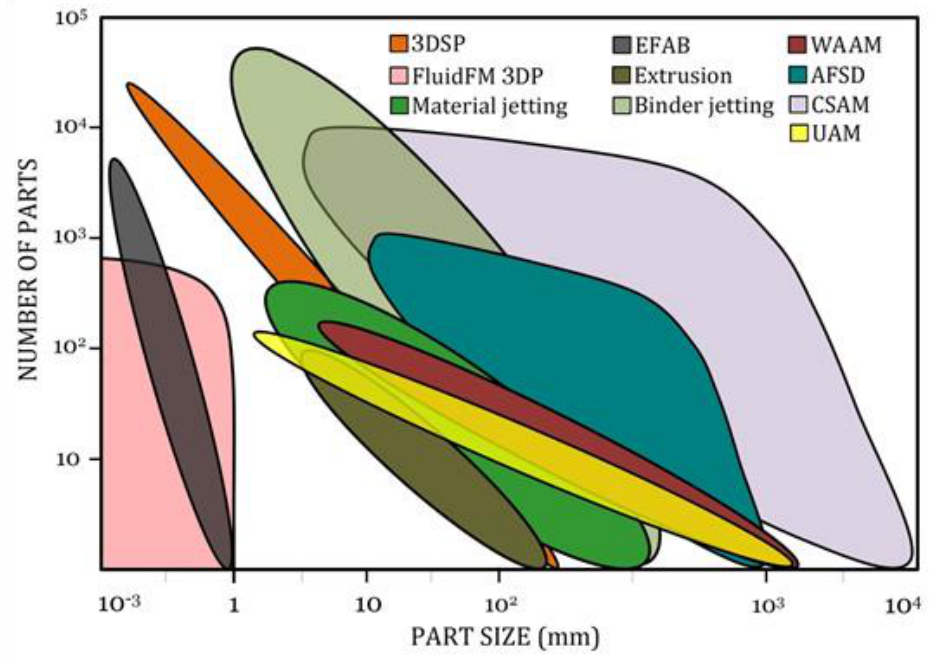
Figure 14. Comparison of the key beamless metal AM systems in terms of part size and productivity. As can be seen, UAM, WAAM, material jetting, extrusion, and FluidFM 3DP are suitable for low-volume production while binder jetting, 3DSP, CSAM, and EFAB have higher deposition rate for high-volume production of metal parts.